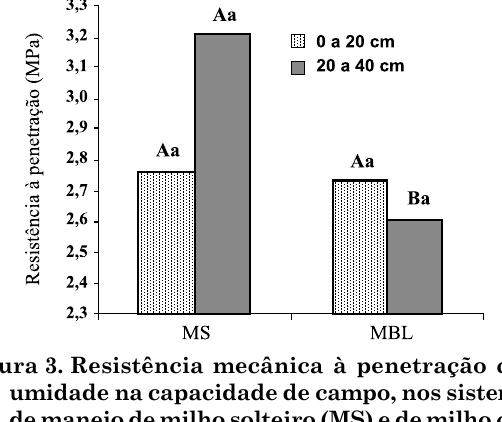
Figura 2. Variação do intervalo hídrico ótimo (IHO) em função da densidade do solo, nos sistemas de cultivo de milho solteiro (MS) e de milho consorciado com braquiária na linha de semeadura (MBL), nas profundidades de 0– 20 cm (a) e 20–40 cm (b).